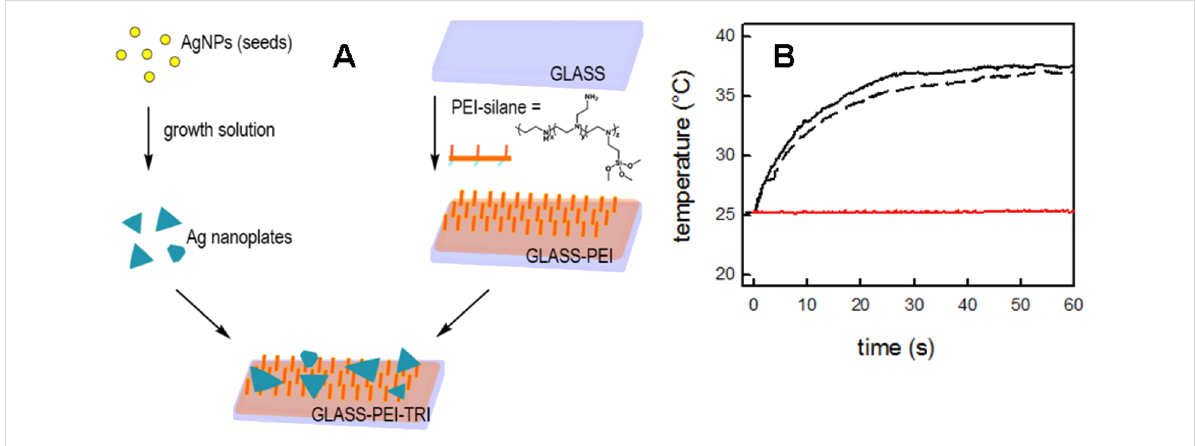
Figure 5: A synthetic preparation route for silver nanoplates on polyethylenimine (PEI)-functionalized glass (A). Temperature increase of grafted silver nanoplates under NIR irradiation (808 nm, 0.26 W/cm 2 ). The red line corresponds to the NIR irradiation on a bare glass surface (B). Figure reprinted with permission from [71], copyright 2017, under the terms of the Creative Commons CC BY License,